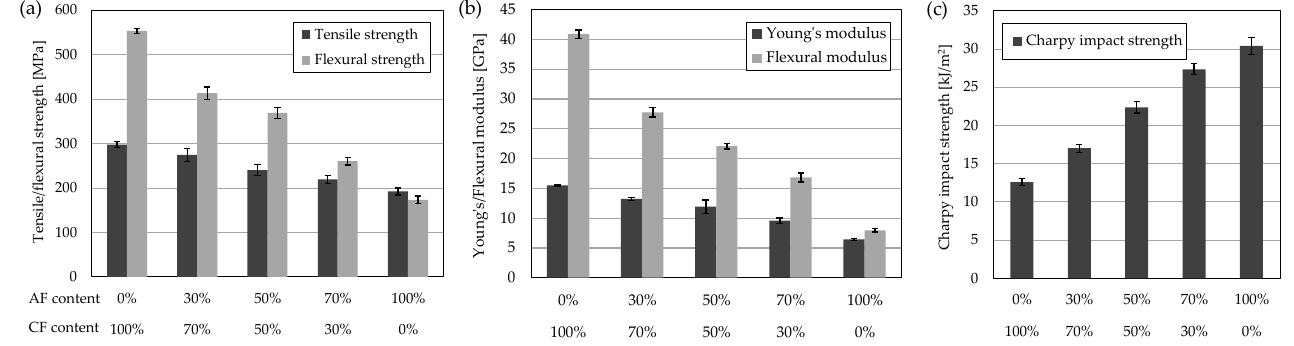
Figure 7. Results mechanical tests: ( a ) tensile and flexural strengths; ( b ) tensile and flexural moduli; ( c ) Charpy impact strength.